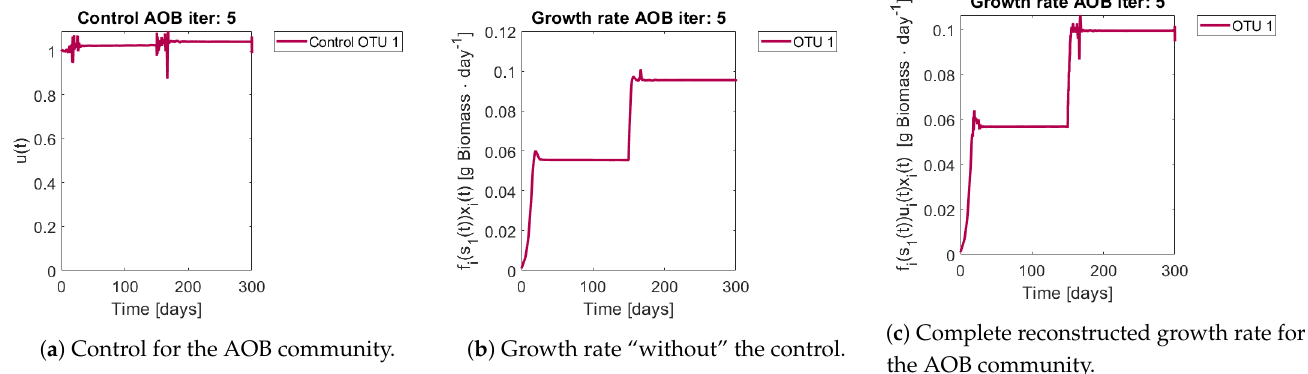
Figure 8. Obtained control and reconstructed growth rate for OTU 1